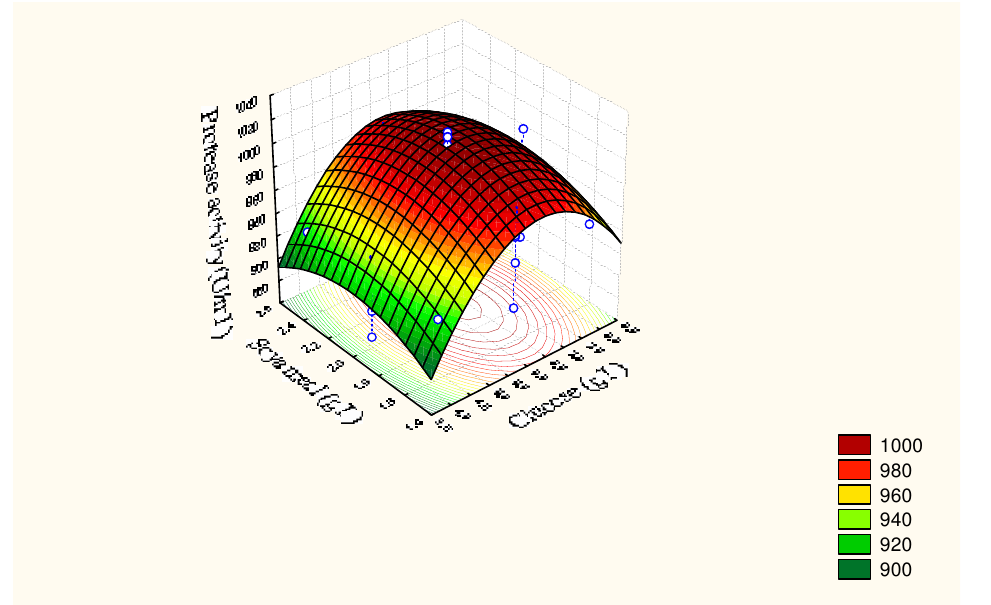
Figure 3(b). Effect of glucose & soya meal on protease